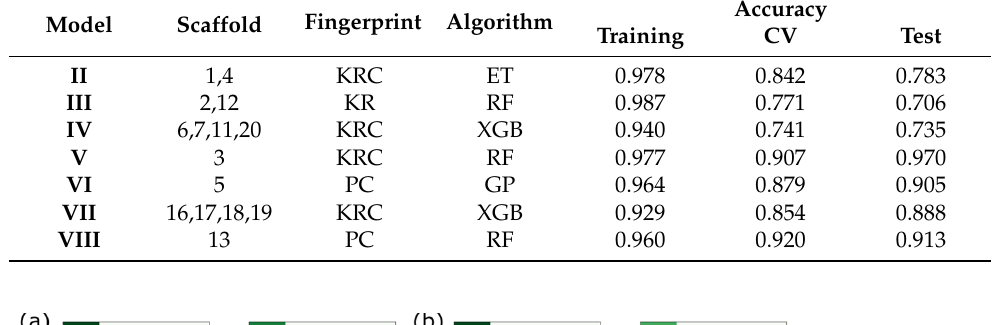
Table 6. Performance metrics for the QSAR classification models of seven groups of scaffolds. Each group contains scaffolds with the same cyclic skeleton. KRC, KR, and PC are the abbreviations for KlekotaRothCount, KlekotaRoth, and PubChem fingerprints, respectively. The accuracy perfor ‐ mance is listed for the training set (Training), 10 ‐ fold cross ‐ validation (CV), and the test set (Test).